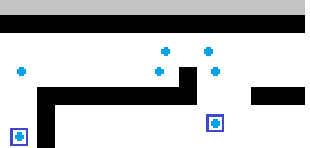
Fig. 3. Goal and target of direct mode are the only points given to the simulator using direct mode